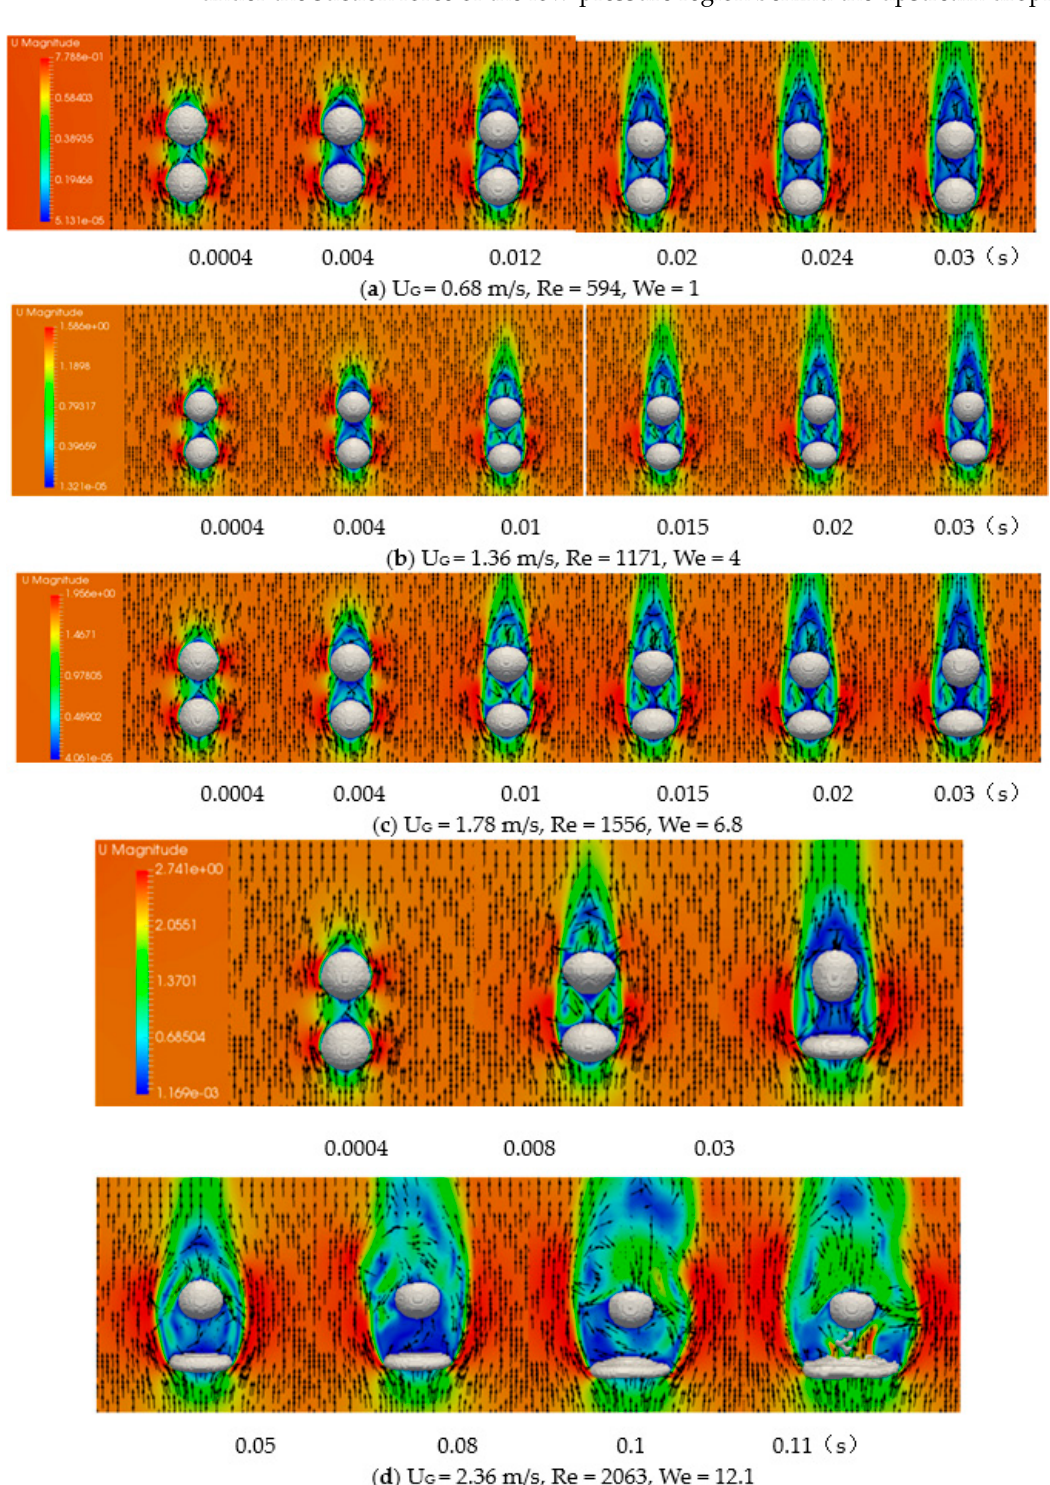
Figure 5. Deformation and breakup of two droplets in tandem with different Weber numbers and a separating space between them of 1.5D.